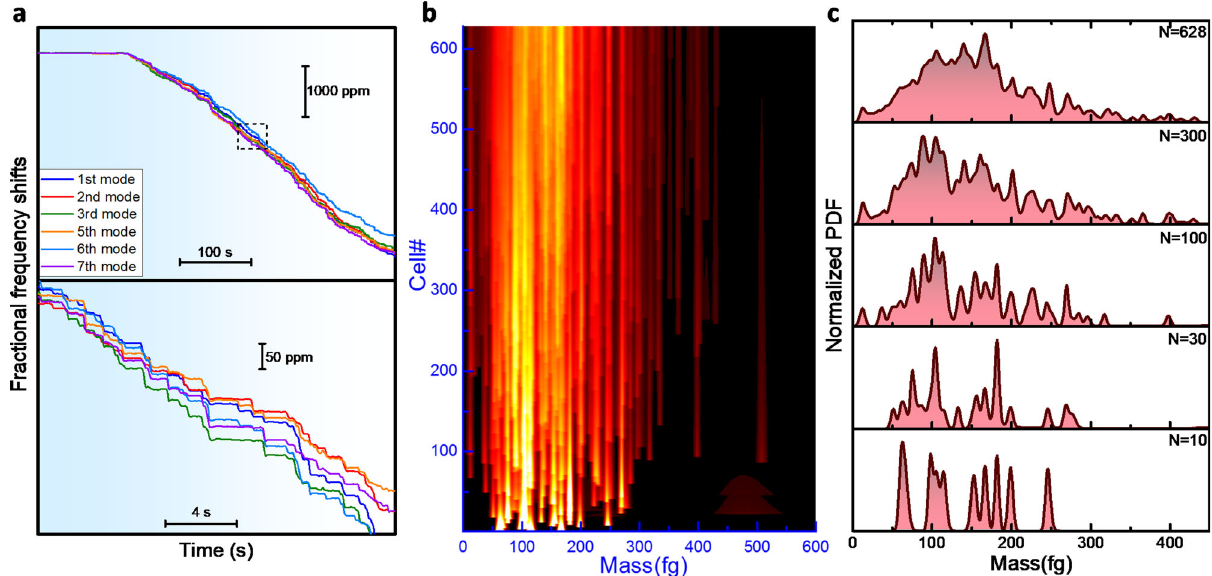
Fig. 4 Nanomechanical spectrometry of a S. epidermidis population. a Real-time record of the fractional frequency shifts of the selected six vibration modes of an ultrathin membrane exposed to a fl ux of charged S. epidermidis cells. Abrupt downshifts of the eigenfrequencies are observed each few seconds. The dashed square of the top graph is zoomed in the below graph for easing the visualization of the adsorption events. b Sequential evolution of the probability distribution function (PDF) of the cell dry mass with the number of adsorbed cells ( c ). Normalized dry mass PDFs after adsorption of the fi rst 10, 30, 100, 300 and 628